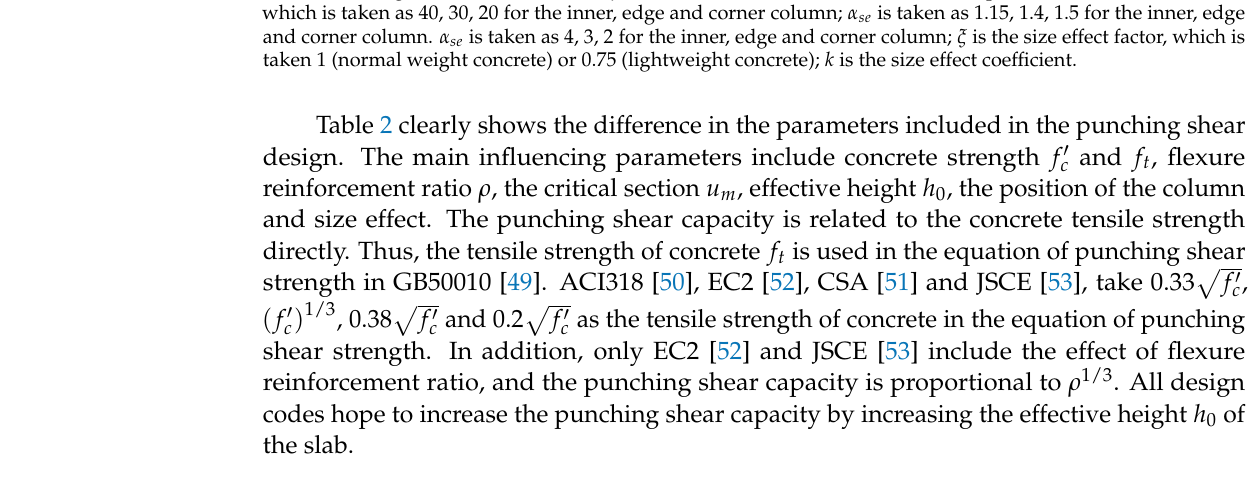
Table 2. Comparison between various punching shear